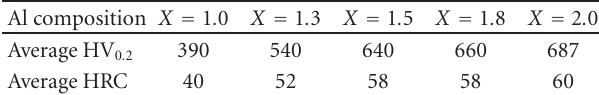
Table 2: The microhardness in di ff erent X values (HV 0 . 2